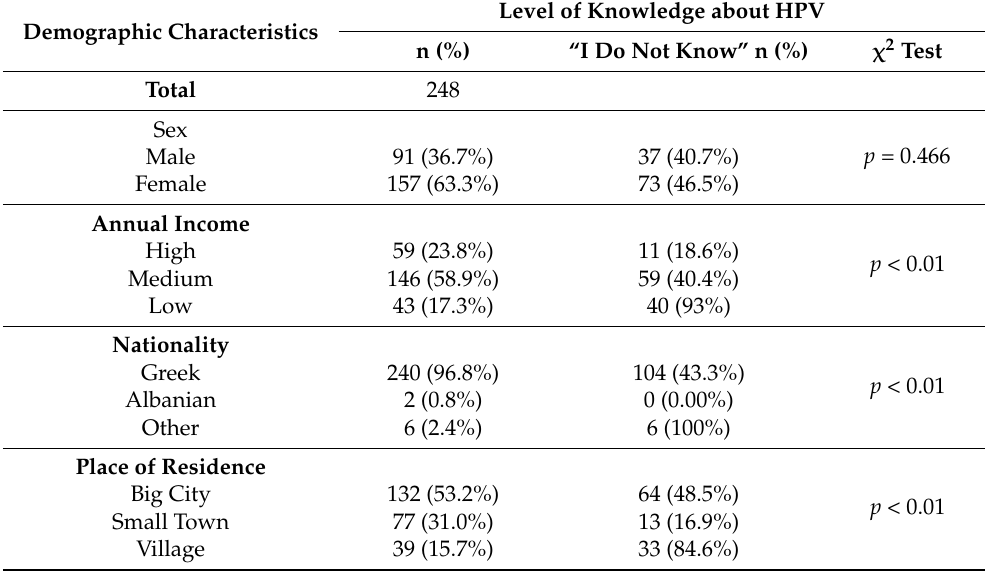
Table 3. Phase II: demographic characteristics of the intervention group correlated with participants’ level of knowledge about HPV (n = 248).